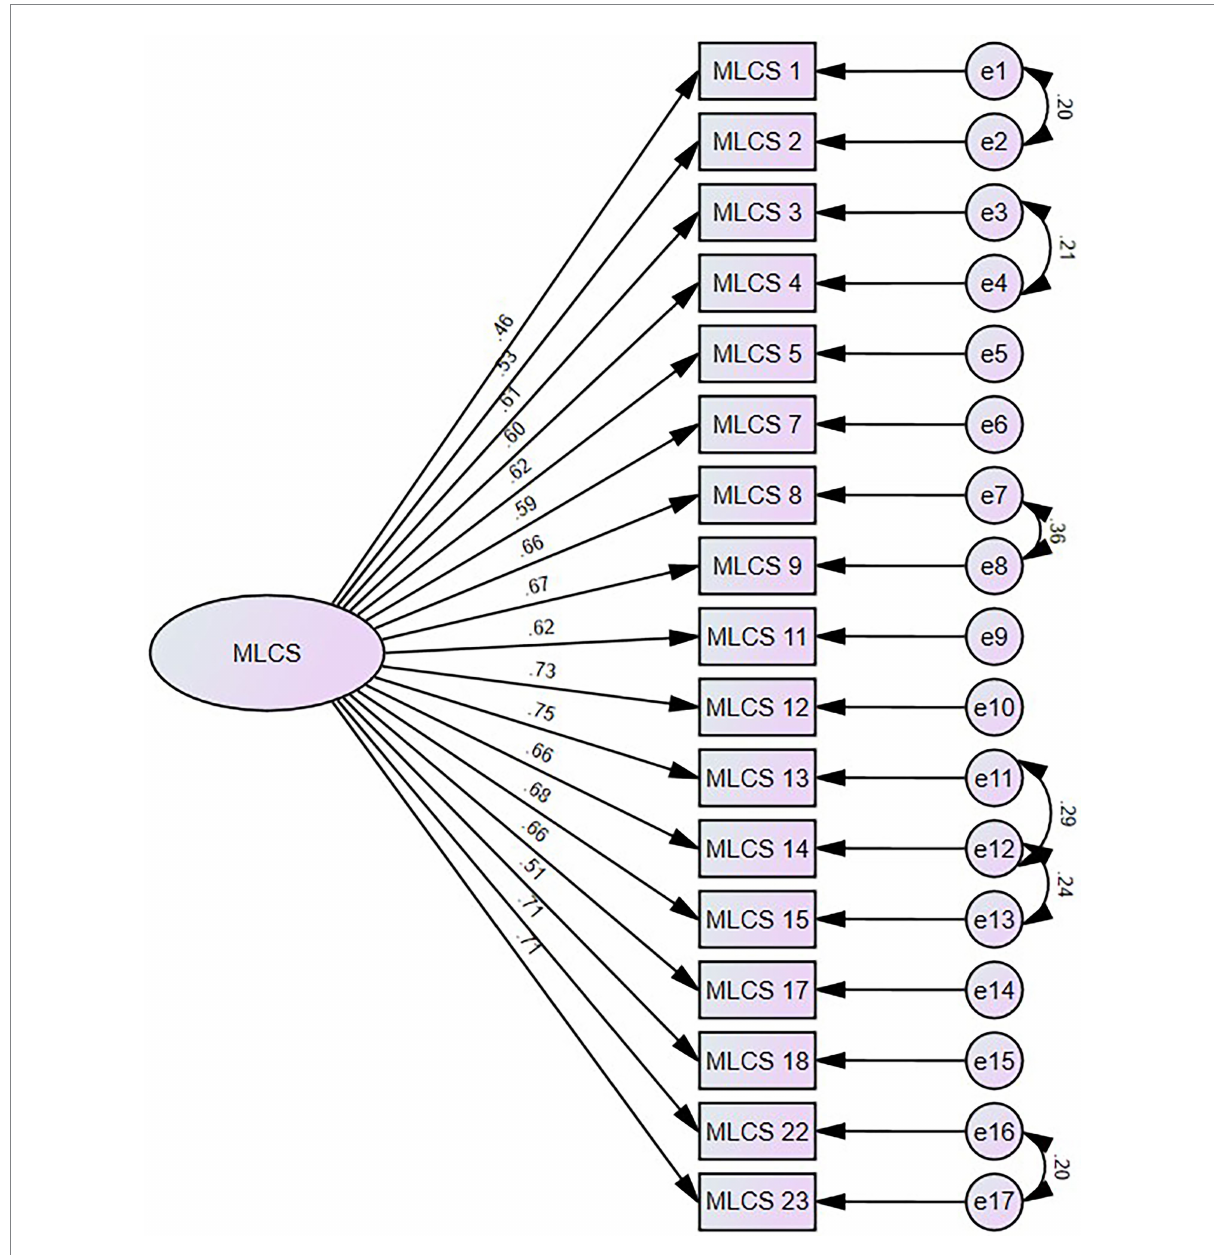
FIGURE 1 Factor structure of learning from mistakes climate scale using confirmatory factor